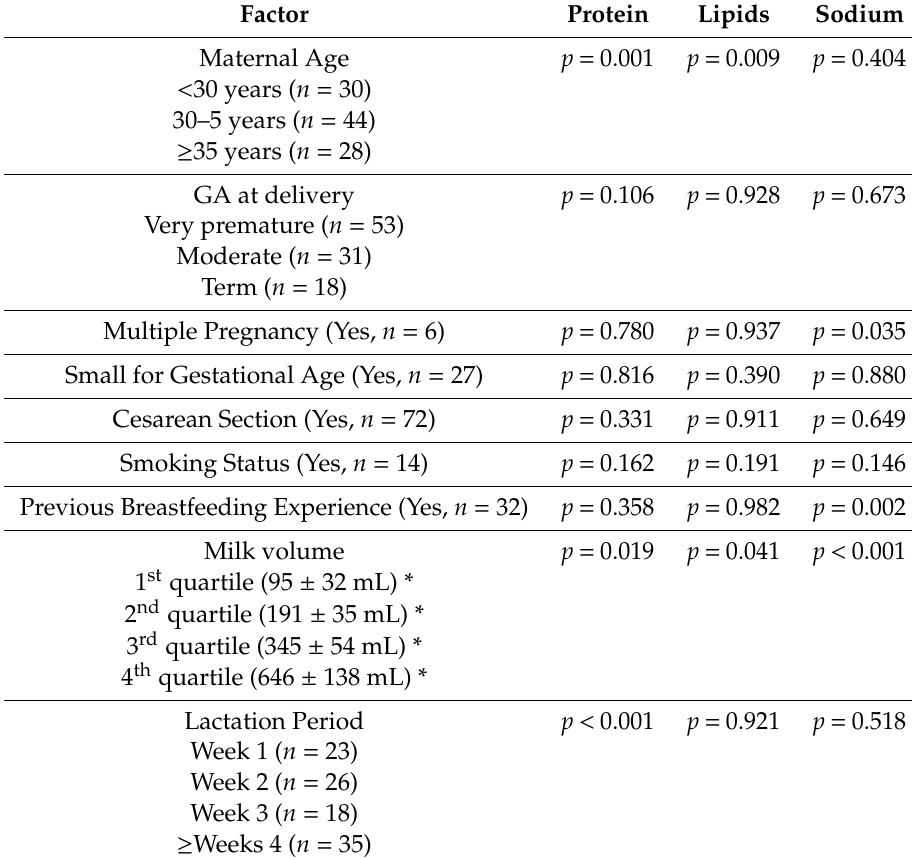
Table 3. Associations between clinical factors and macronutrient and sodium concentrations expressed in quartiles from 102 milk samples.